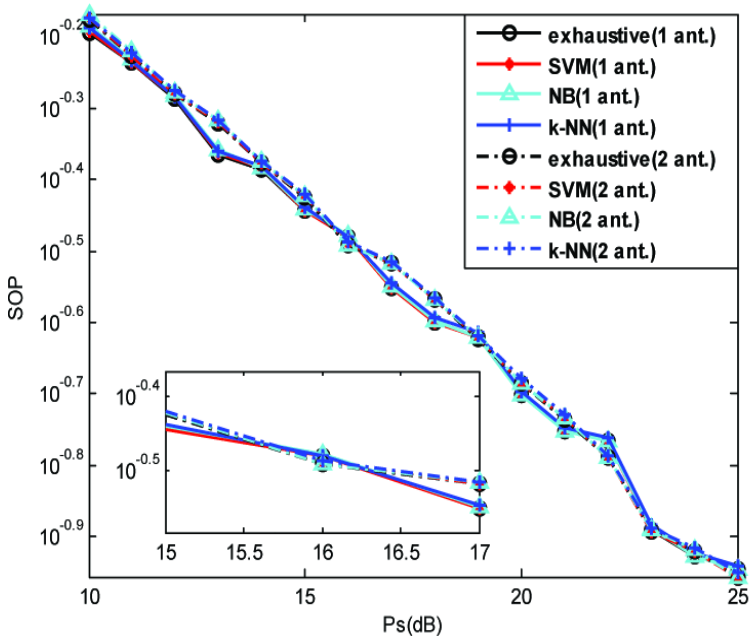
Figure 5. Secrecy Outage Probability ( SOP) of single- and two- antenna selection for β = 1 and Rt = 2 bps/Hz [73].